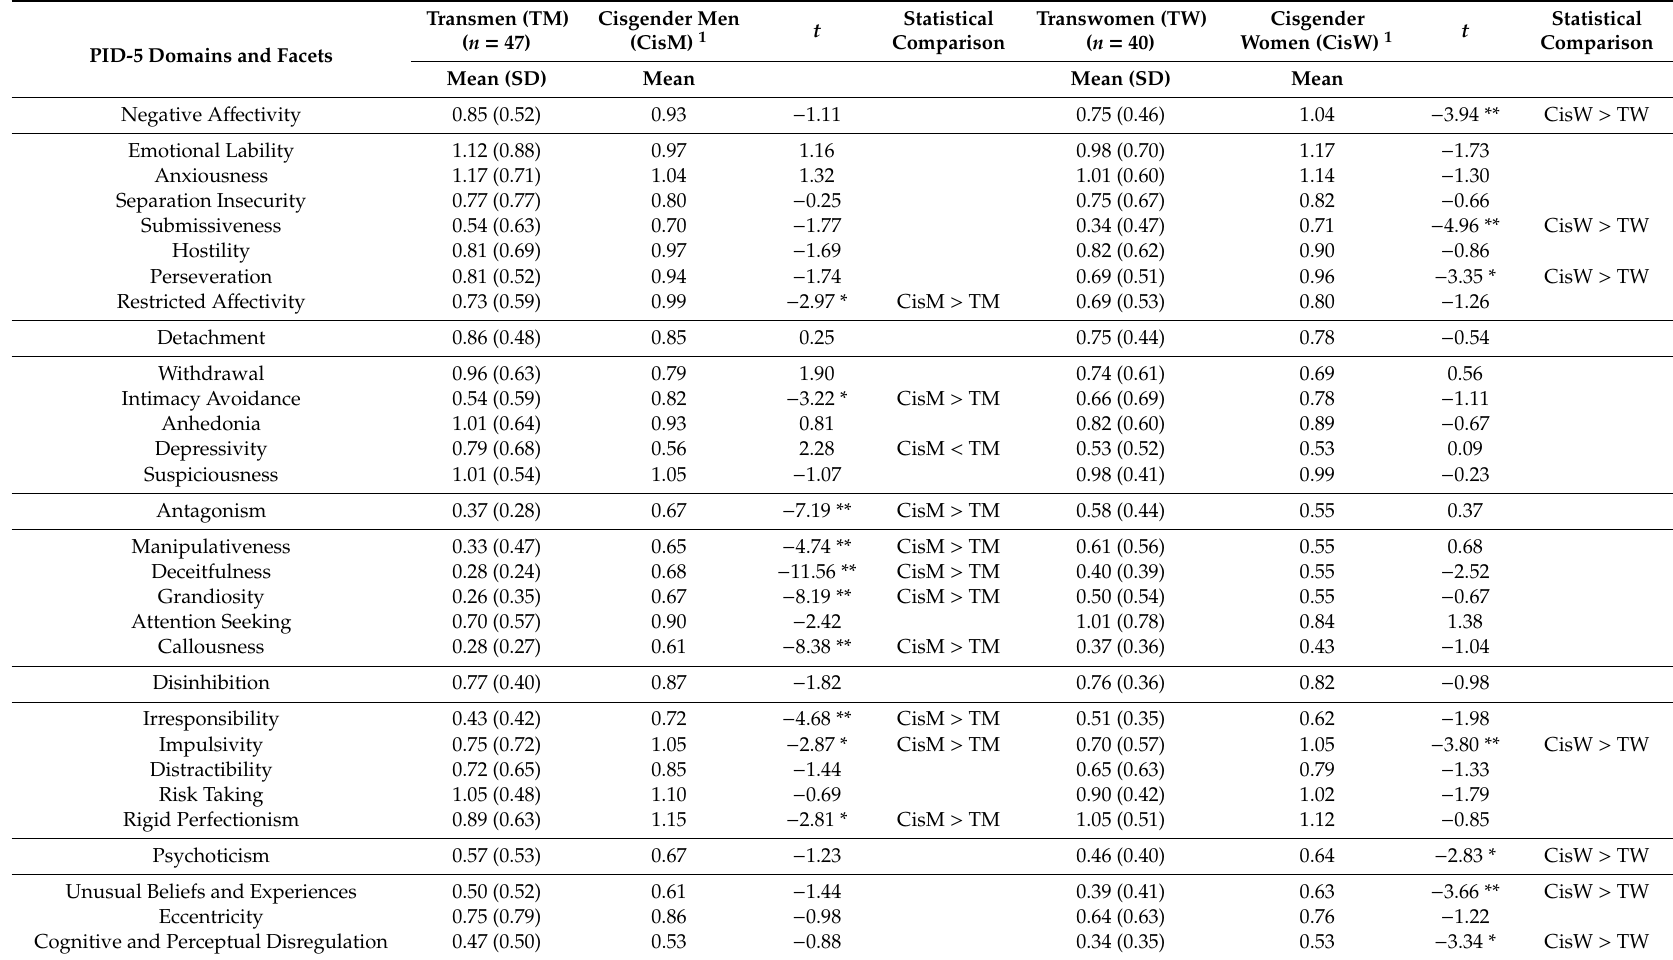
Table 2. PID-5 descriptive statistics for PID-5 domains and facets and comparisons between transgender and cisgender women and transgender and cisgender men.